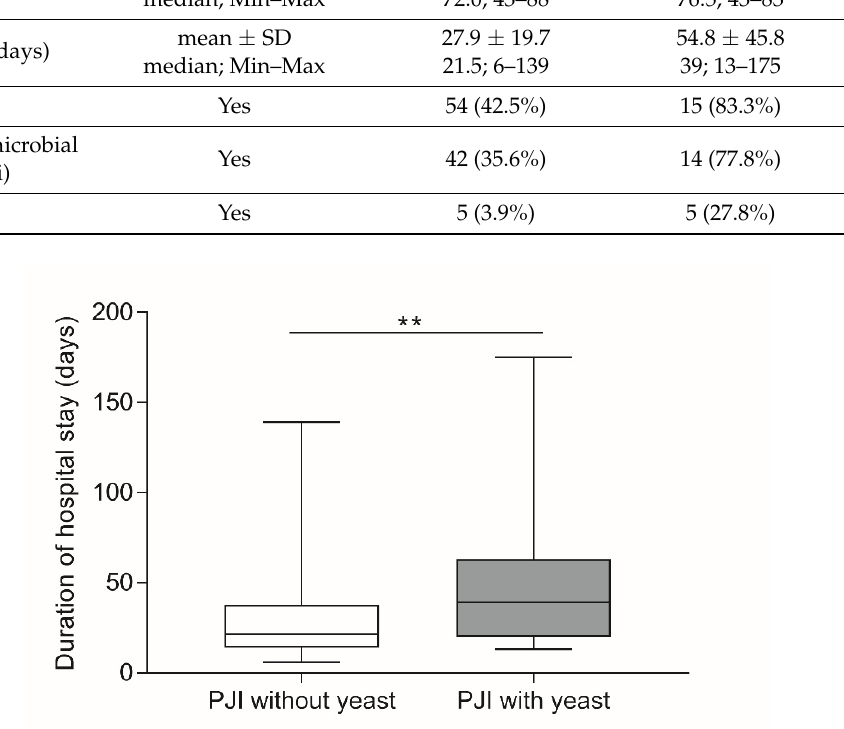
Figure 2. Hospital stays in days. Duration of the hospital stay was calculated as the period in which the patient stayed continuously at the University Rostock Medical Centre. Rehabilitation was not included in the hospital stay. The data are presented as boxplots with the minimum, 25th percentile, median, 75th percentile, and maximum. Significances between groups were calculated with the Mann–Whitney U test (** p <